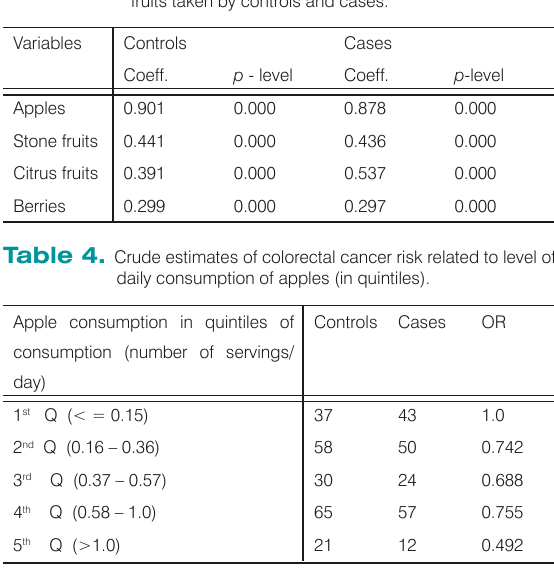
Table 3. Partial correlation between average number of all fruit servings per day and most common kinds of individual fruits taken by controls and cases.